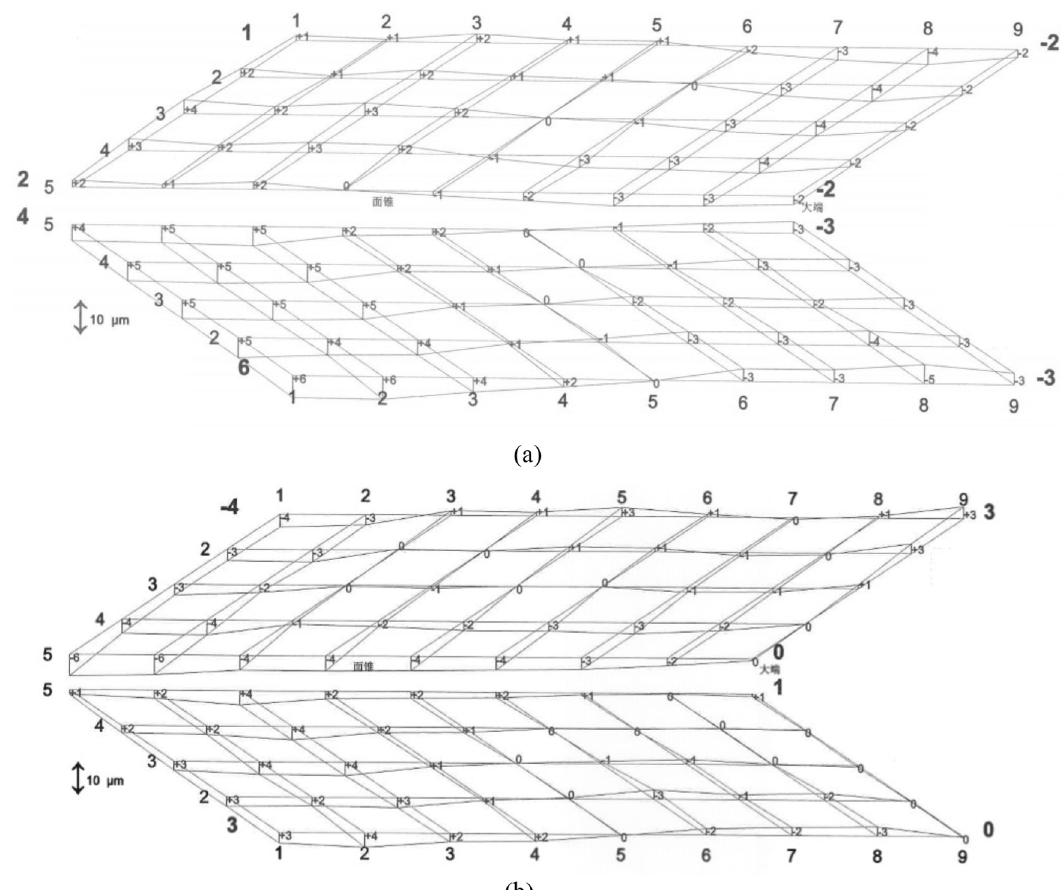
Fig. 15. Measurement results of tooth surface. (a) Gear. (b)